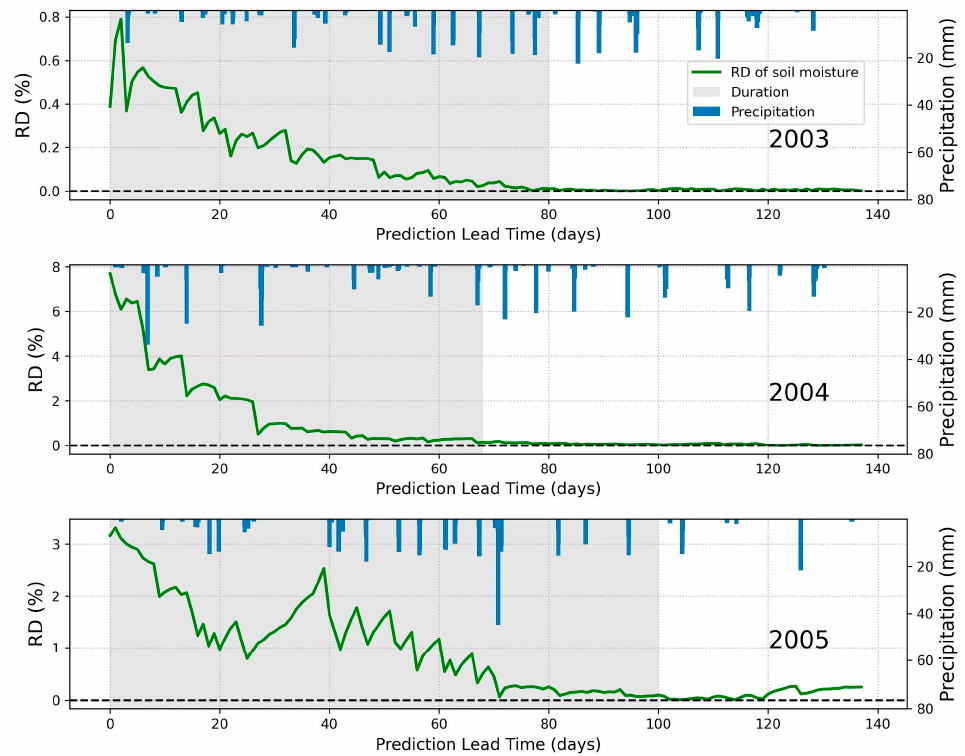
Figure 8. RD between OL and MLDAS of soil moisture prediction in scenario I in 2003, 2004, and 2005. The shaded area represents the duration of influence brought by assimilation on future predictions.